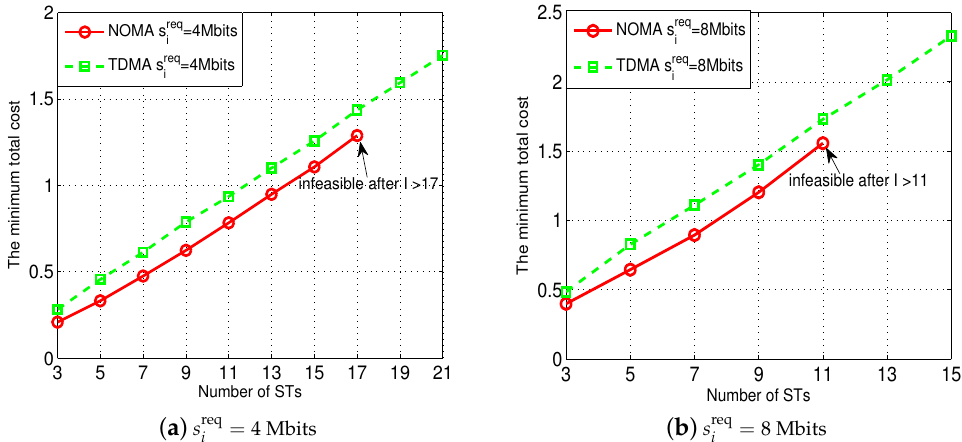
Figure 8. Performance of our proposed NOMA transmission scheme under different numbers of STs. Each point denotes the average result of 100 sets of the random realizations of the STs’